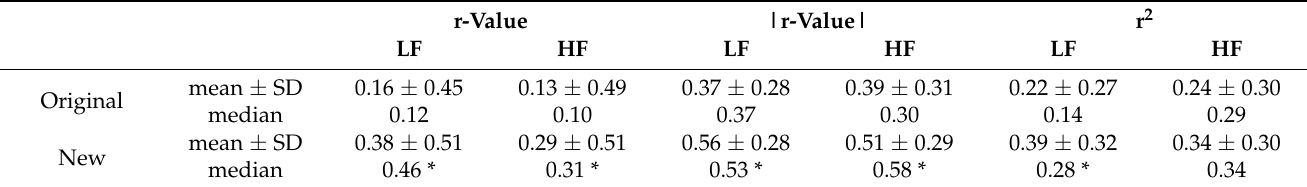
Table 7. The correlation between stroke volume variability (SVV) and heart rate variability (HRV) in all stages with different SVV bandwidths (Original bandwidth: LF: 0.04–0.15, HF: 0.15–0.4;